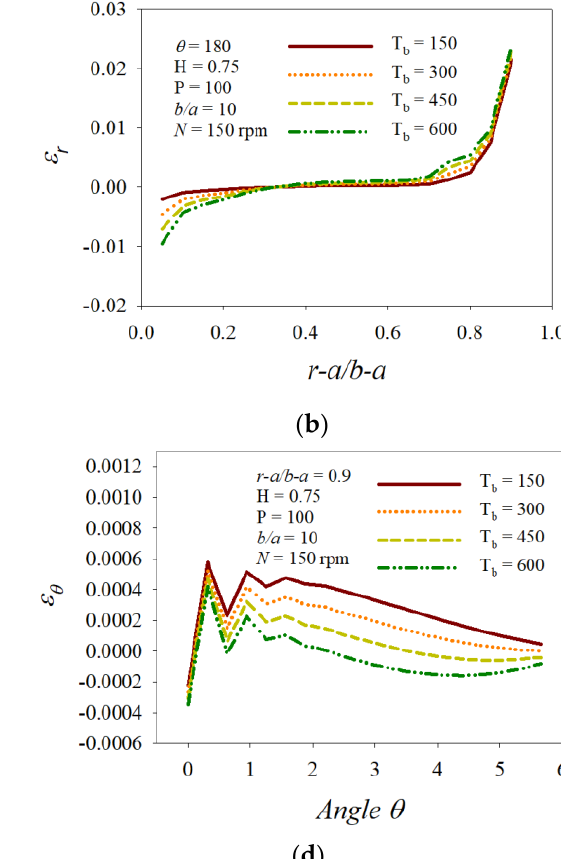
radial at θ = 180 , ( c ) circumferential at ( r − a)/(b − a) = 0.1, ( d ) circumferential at (r − a)/(b − a) dial at θ = 180, ( c ) circumferential at (r − a ) / ( b − a ) = 0.1, ( d ) circumferential at ( r − a ) / ( b − a ) =